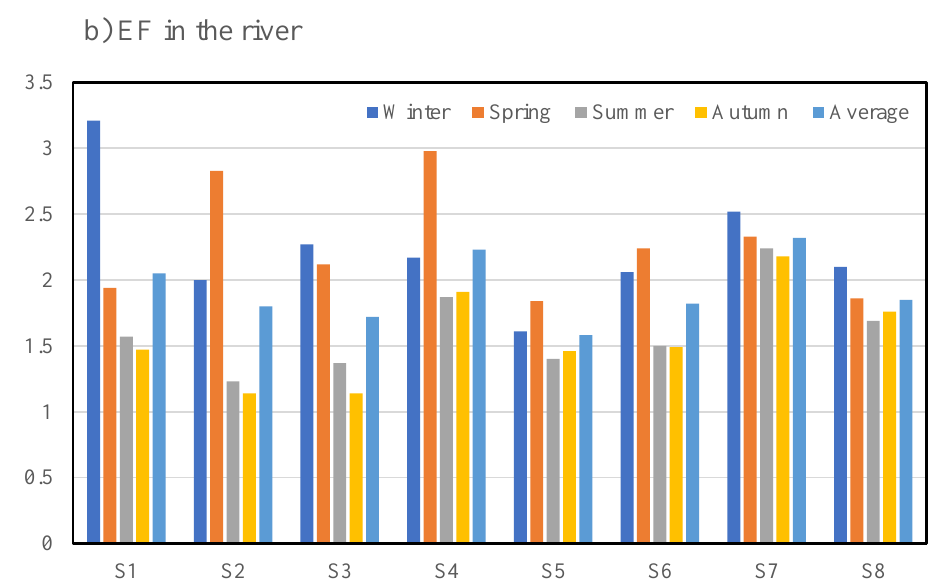
Figure 5. The seasonal variation of nutrient pollution evaluated by enrichment factor (EF) in the surface sediment of ( a ) Lake Yangcheng including three lake regions and ( b ) eight connected (inflowing) rivers.